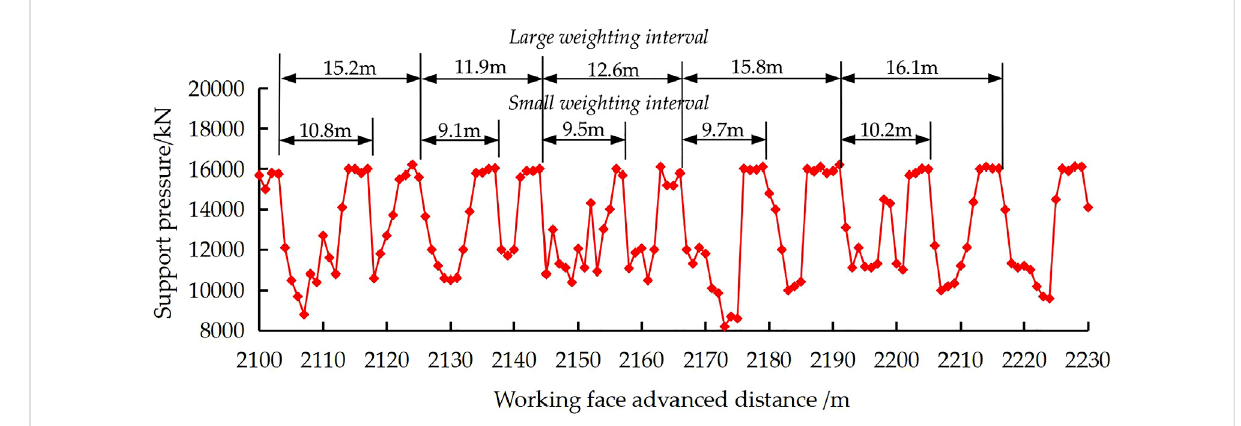
FIGURE 9 Resistance curve of no.63 support.